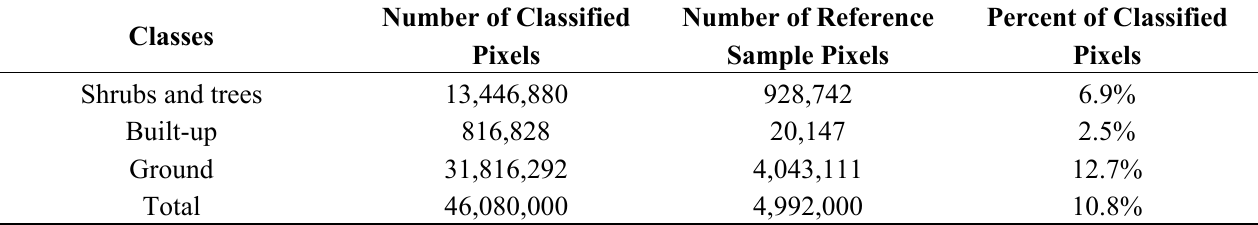
Table 4. The number of classified pixels and reference pixels in each of the three classes related to the classification where only the CIR orthoimages were used.